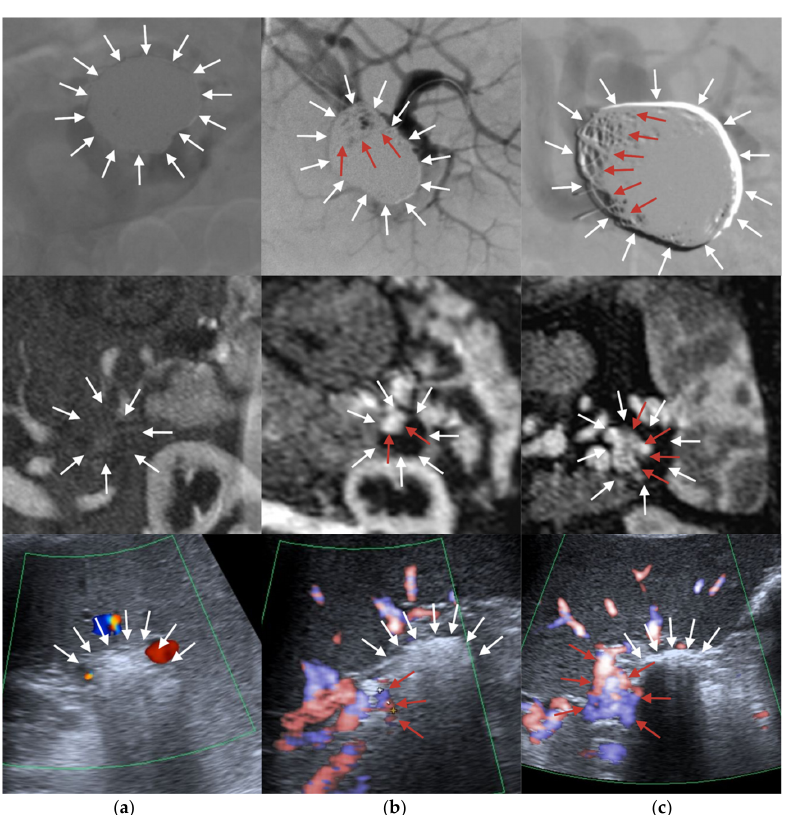
Figure 1. Images were taken with the use of the investigated imaging modalities: digital subtraction angiography (DSA) in the first row, magnetic resonance angiography (MRA) in the second row, and color Doppler ultrasound (DUS) in the last row. In columns, different aneurysm occlusion classes were presented, respectively, for each imaging modality: ( a ) Class I—complete occlusion; ( b ) Class II—residual neck; ( c ) Class III—residual aneurysm. White arrows—aneurysm after embolization; red arrows—aneurysm sac reperfusion.